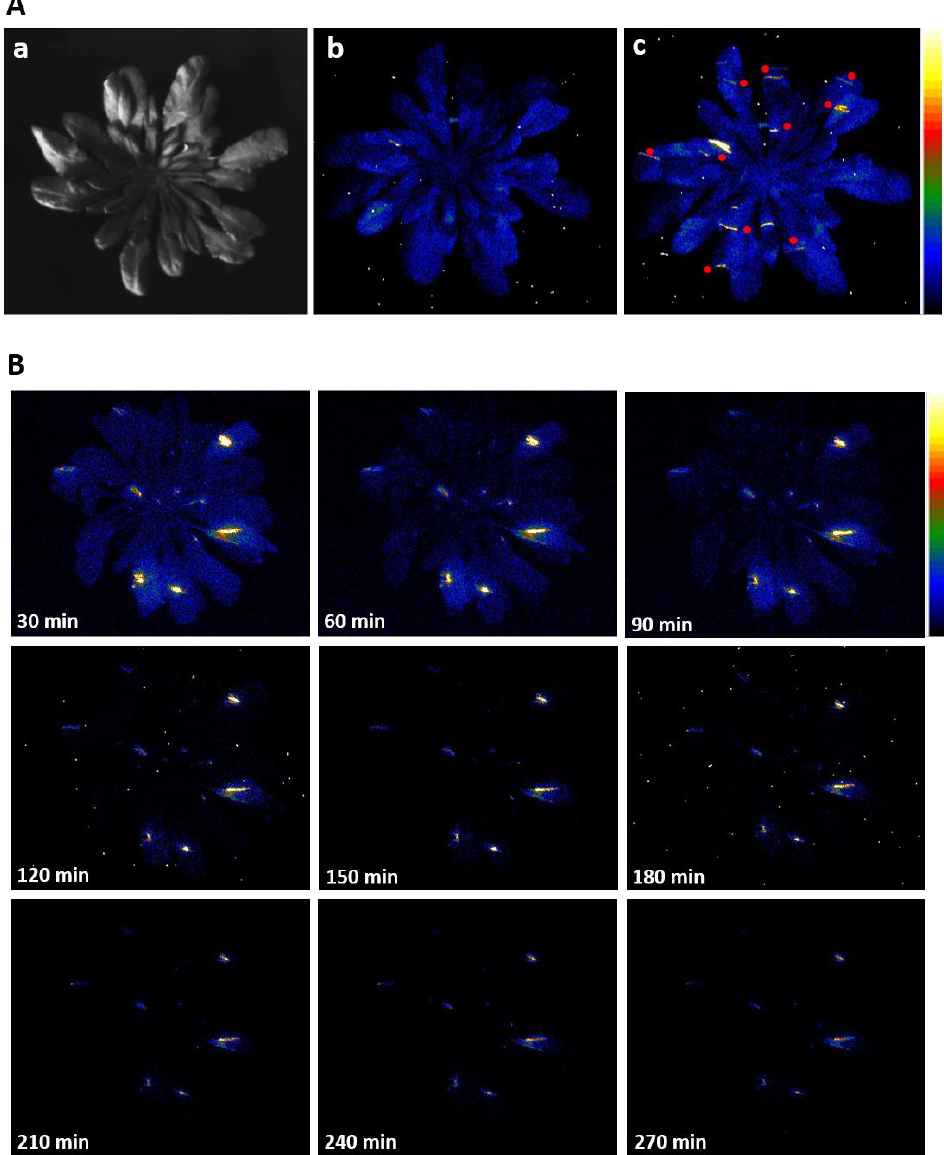
Figure 2. ( A ) Two-dimensional imaging of the ultra-weak photon emission from the Arabidopsis plants. The figure shows photographs ( a ) and the corresponding two-dimensional images of ultra-weak photon emission from non-wounded ( b ) and wounded ( c ) Arabidopsis plants. The plants were dark-adapted under weak green light for a period of 2 h before wounding. Mechanical injury was done under diffused green light and the sites are indicated by red dots within the image. The measurement was started 30 min after the mechanical injury with an accumulation time of 30 min. ( B ) Two-dimensional images of ultra-weak photon emission from wounded Arabidopsis plants under the condition described in ( A ) and subsequent images of the same plant were taken for 270 min each with 30 min accumulation time and variable dark adaptation (as indicated).